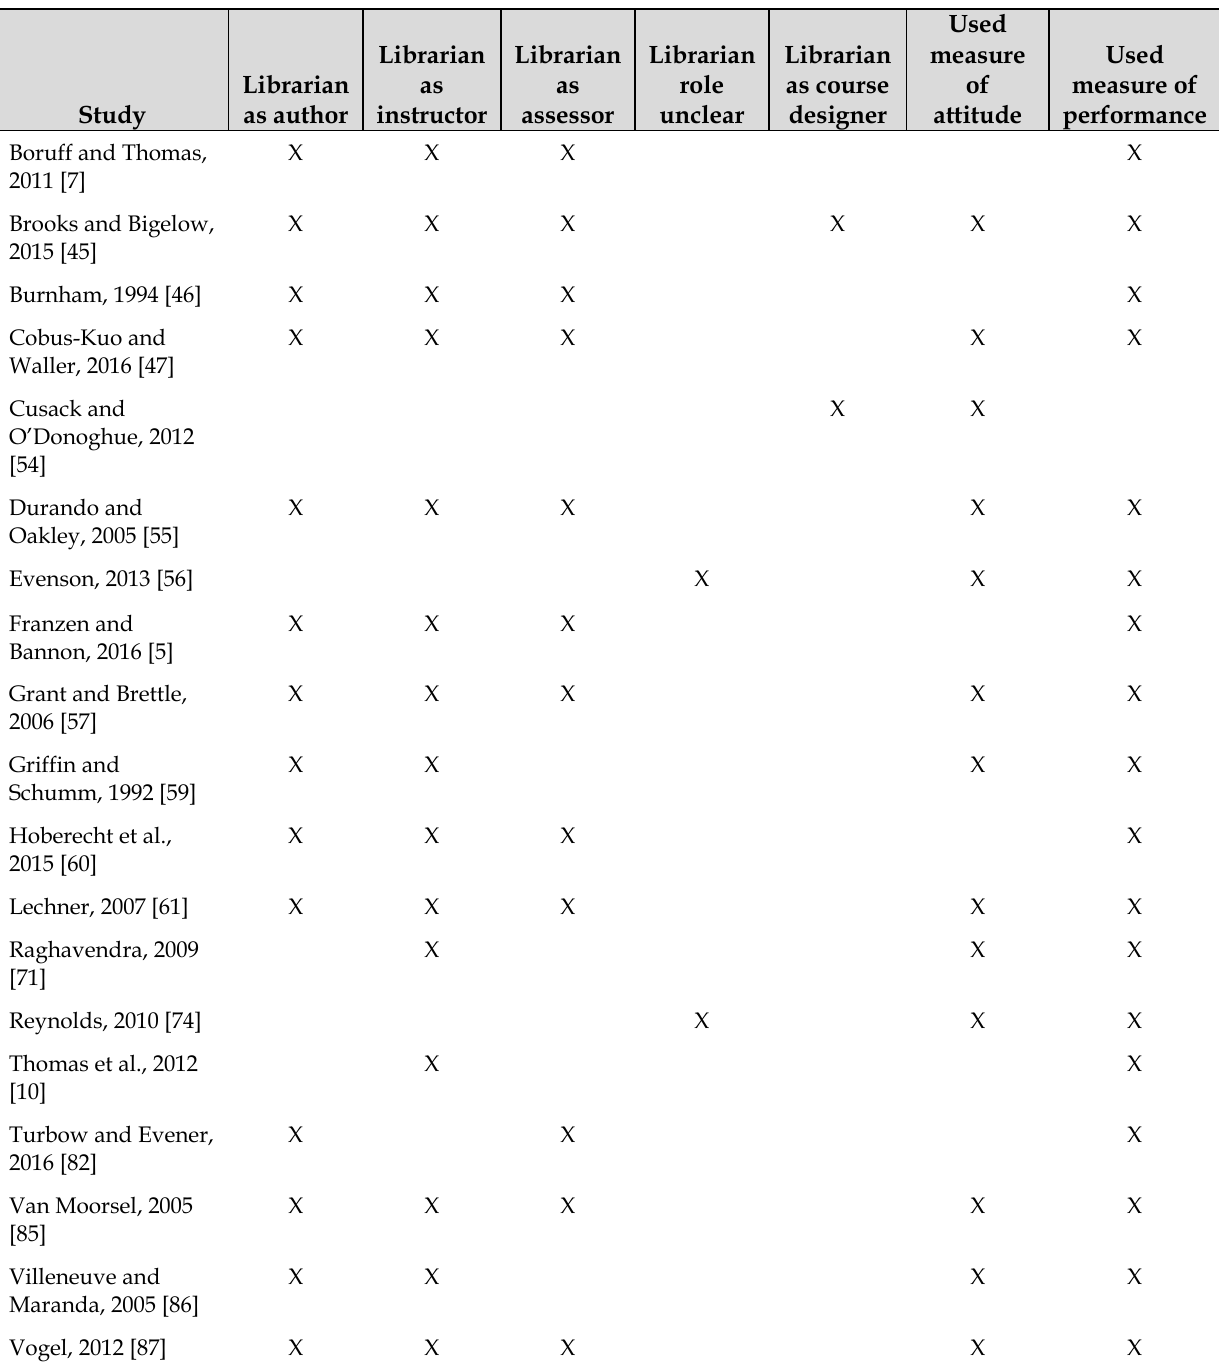
Table 3 Librarian role in the study and assessment measures used